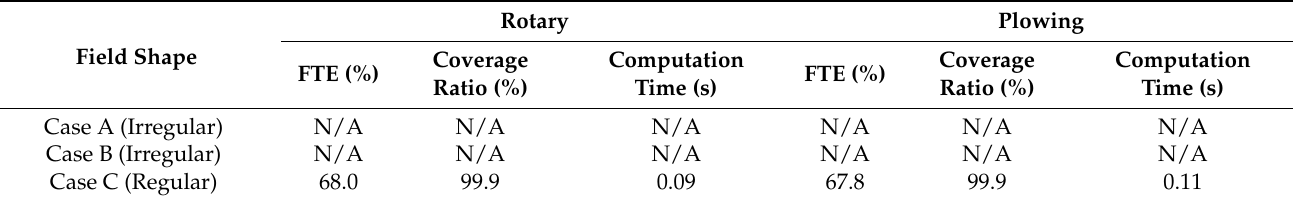
Table 5. Results from C-type turning